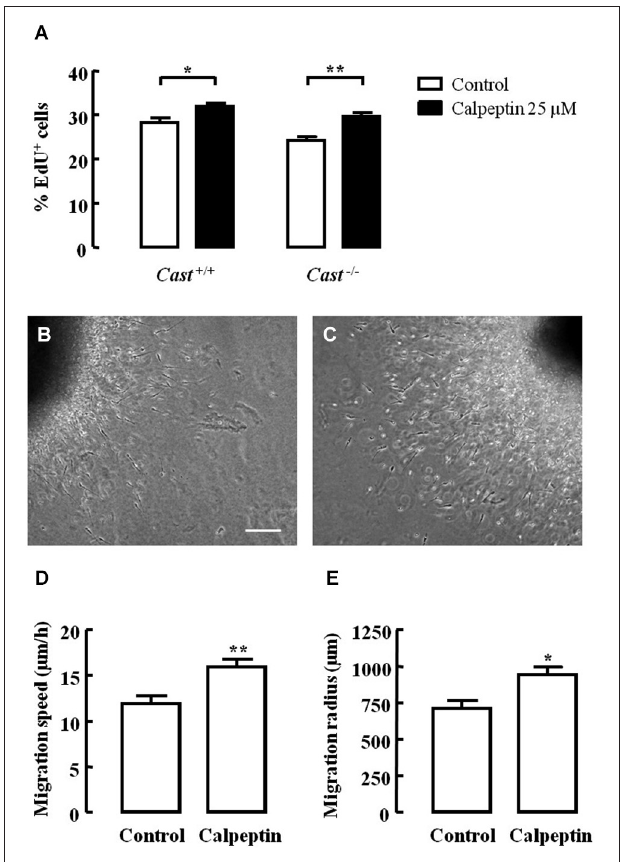
FIGURE 6 | Calpain inhibition increases NSC proliferation and cell migration in Cast + / + cells and rescues cell proliferation in Cast − / − cells . Percentage of living cells positive for EdU (A) . Representative images of SVZ explants untreated (B) or with calpeptin 25 µ M (C) . Migration speed (D) and radius (E) of cells migrating out of the SVZ explants. Means ± SEM of at least 3 independent experiments. Two-way ANOVA (Bonferroni’s post-test) (A) or two-tailed t -test (D) and (E) , * p < 0.05 and ** p < 0.01 (significantly different from control). Scale bar: 100 µ